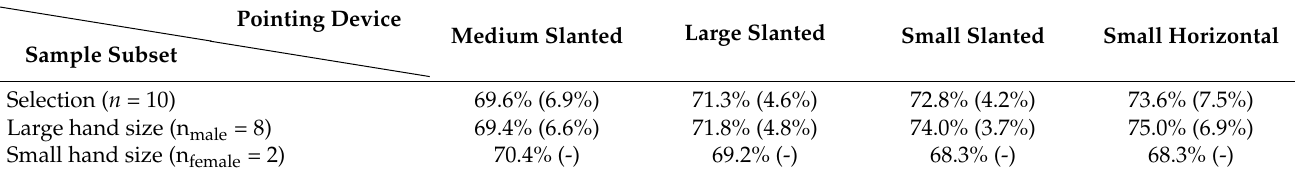
Table 6. Mean weighted efficiency values obtained from purpose-built software [11] recorded objective data for a randomly selected subset of participants ( n = 10); (standard deviation shown in parentheses where